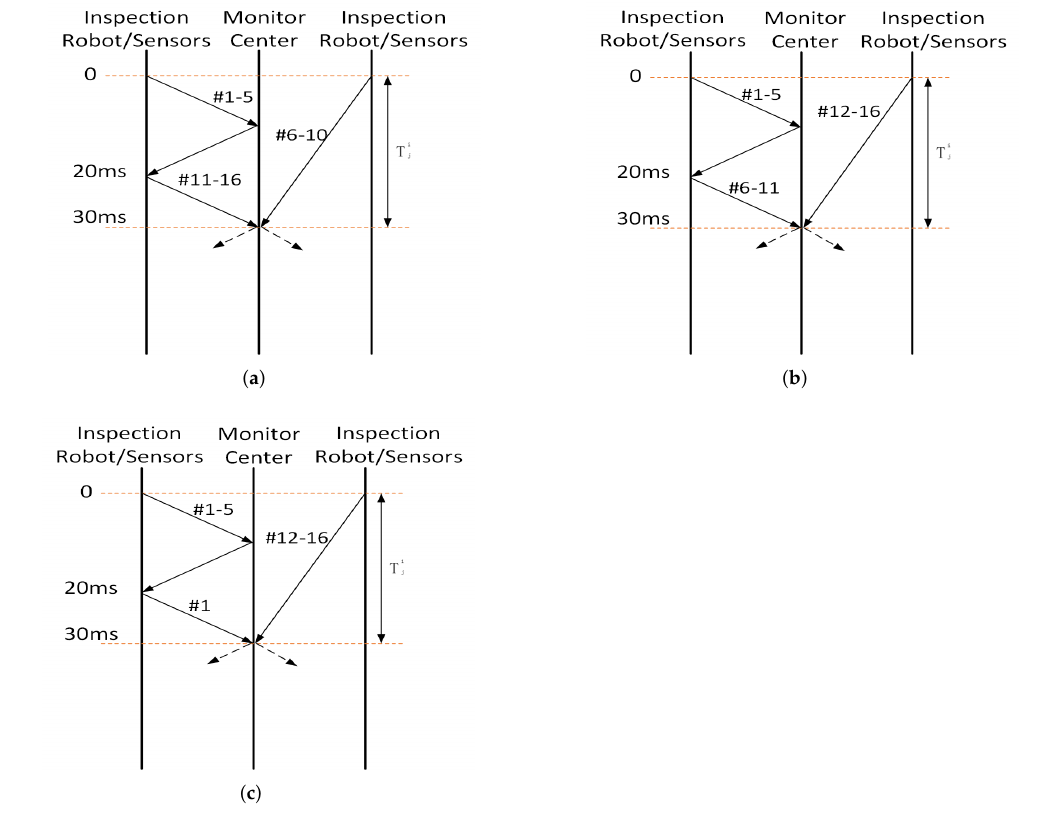
Figure 1. Pre-allocating can alleviate the OFO problems and its performance can be affected by random packet losses. ( a ) Packets 1–5 are disorder packets. ( b ) No packet loss and no OFO. ( c ) The OFO packets cannot be avoided when packet loss exists even with pre-allocating